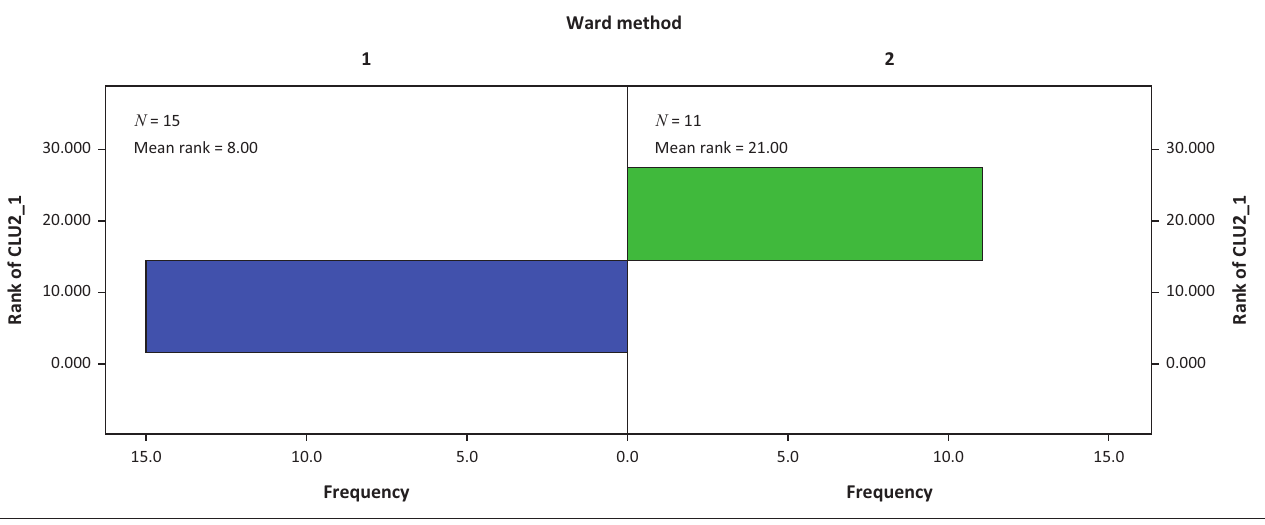
FIGURE 5: Independent samples Mann–Whitney U test.